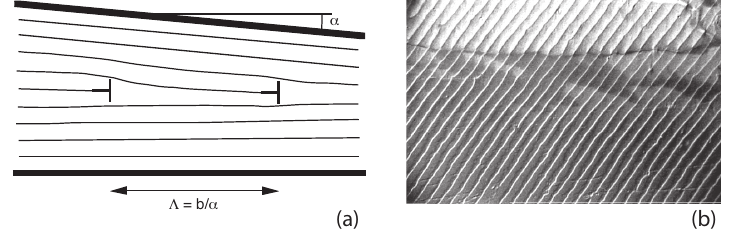
Figure 11. Geometrical dislocations ( a ) and their aspect under the microscope between crossed polarizers close to the SmA-SmC phase transition ( b ) (photo by S. Lagerwall,